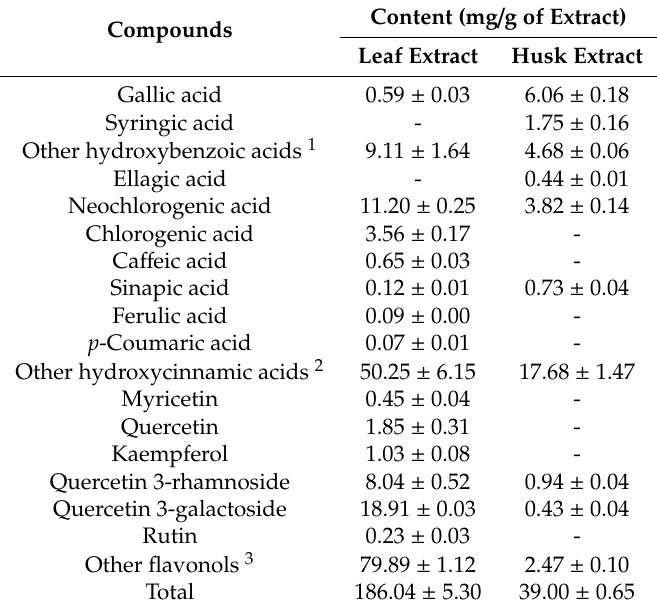
Table 2. Phenolic compounds content in walnut leaf extract and walnut husk